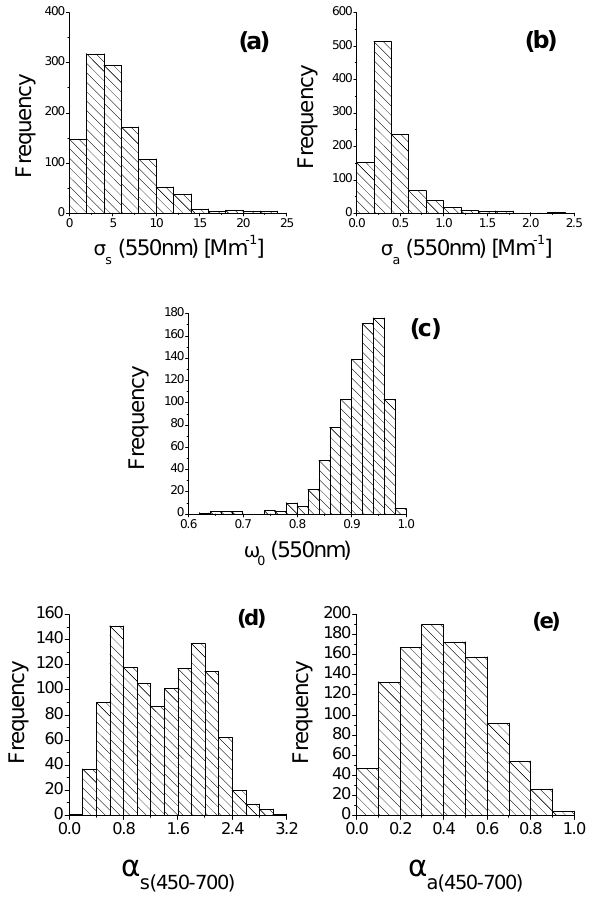
Fig. 3. Frequency histogram for the (a) σ s , (b) σ a , (c) ω 0 , (d) α s and (e) α a